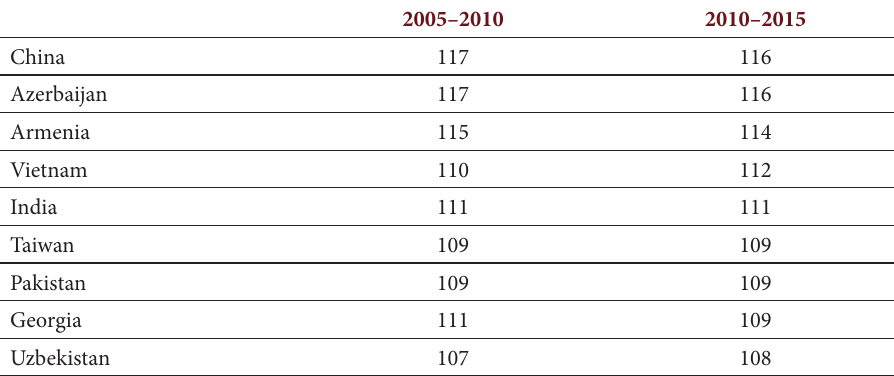
Figure 11. Dynamics of births and sex ratio at birth in Azerbaijan, 1990-2017. Source: according to SSC data. Table 2. Sex ratio at birth in Azerbaijan and some countries of the